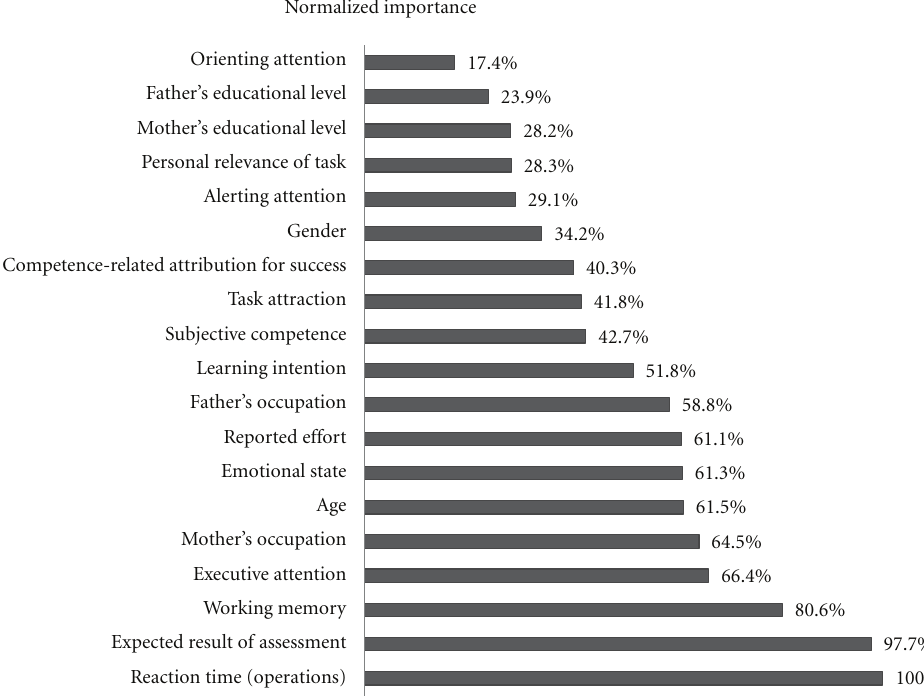
Figure 1: Normalized importance of the top variables participating in the model for the predictive classification of the lowest 30% of scores in the mathematics test.